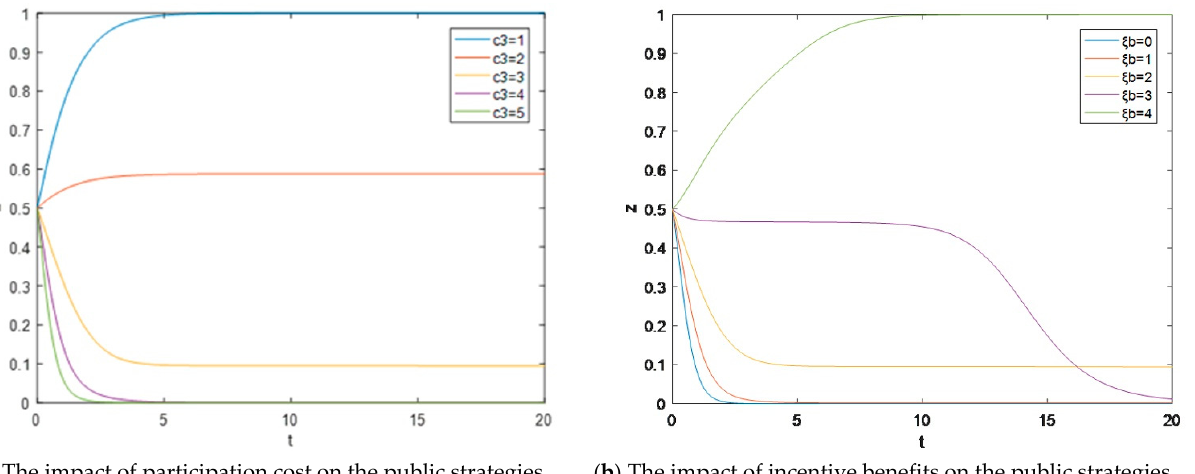
Figure 16. The impact of participation cost and incentive benefits on the public strategies